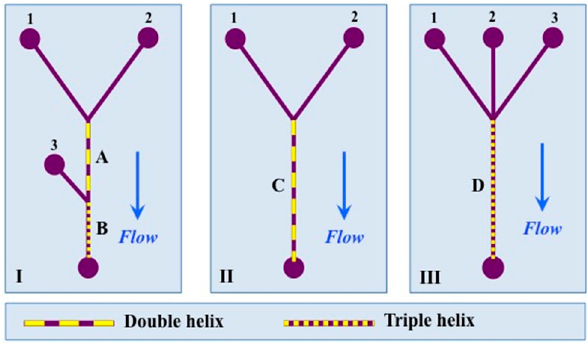
Figure 4. A schematic presentation of the three designs used in this work (not to